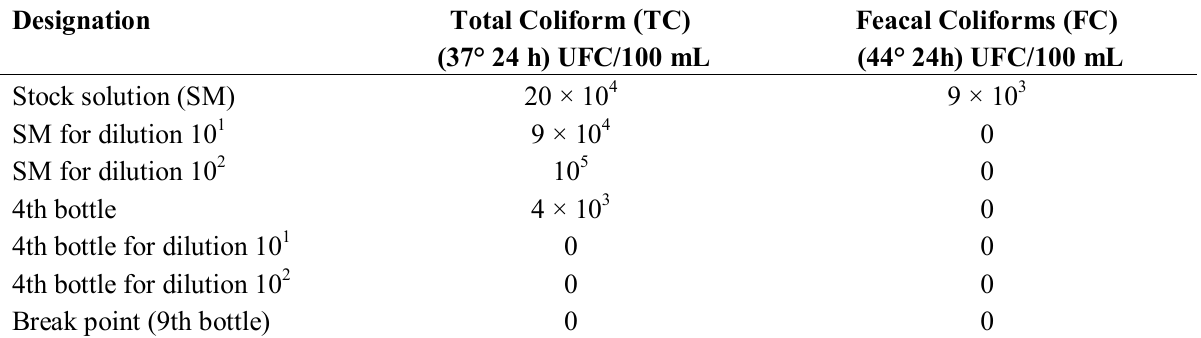
Table 5. Results of the bacteriological tests of the disinfected treated